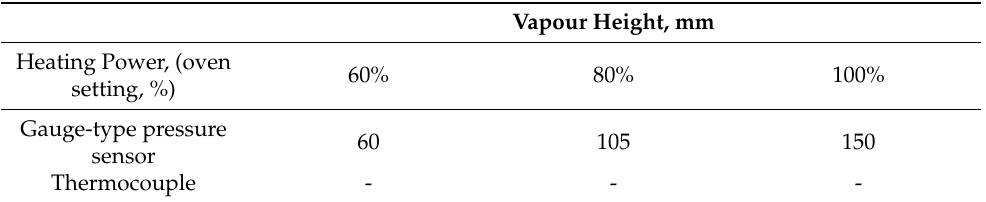
Table 2. Comparison of two different sensors by vapour height